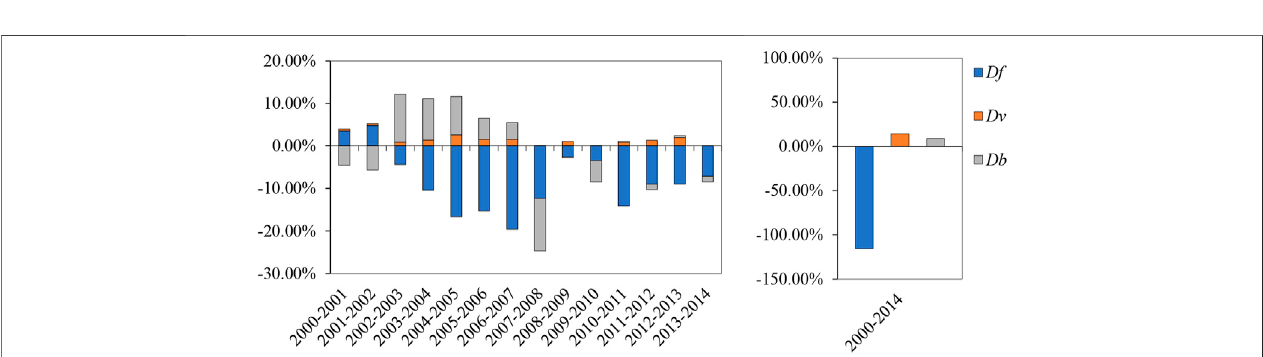
Frontiers in Environmental Science |